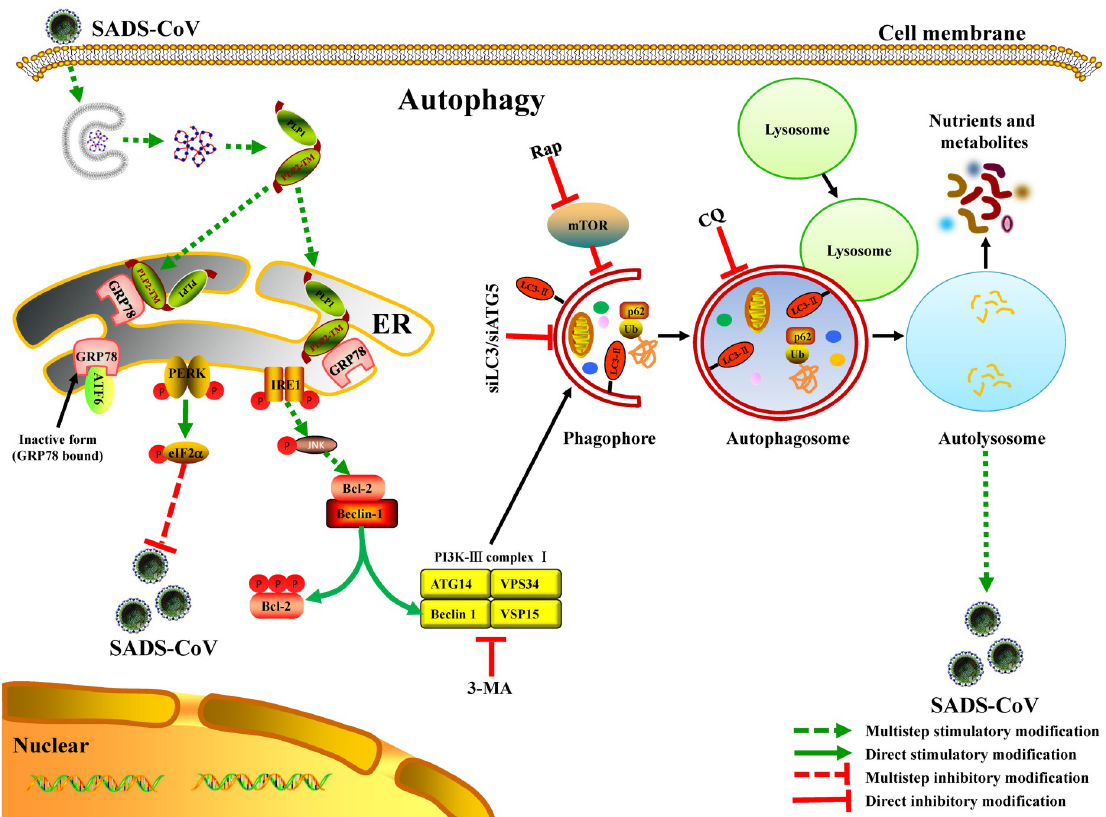
Fig 11. Graphical illustration of the IRE1-JNK-Beclin 1 signaling pathway involved in SADS-CoV-induced autophagy via PLP2-TM and GRP78